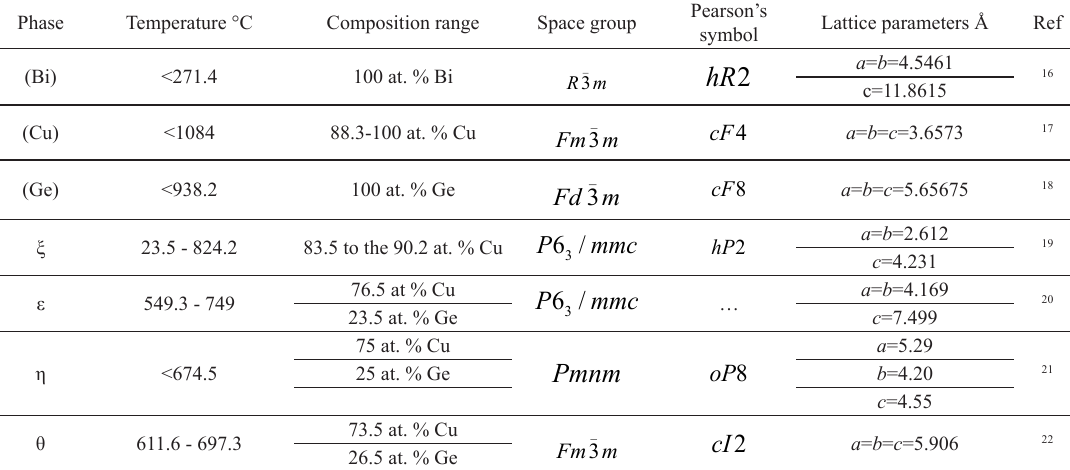
Figure 2. Cu-Ge phase diagram calculated using thermodynamic data established by Wang et al. 14 . Table 1. Crystal structure data for the solid phases in the Bi-Cu-Ge system.